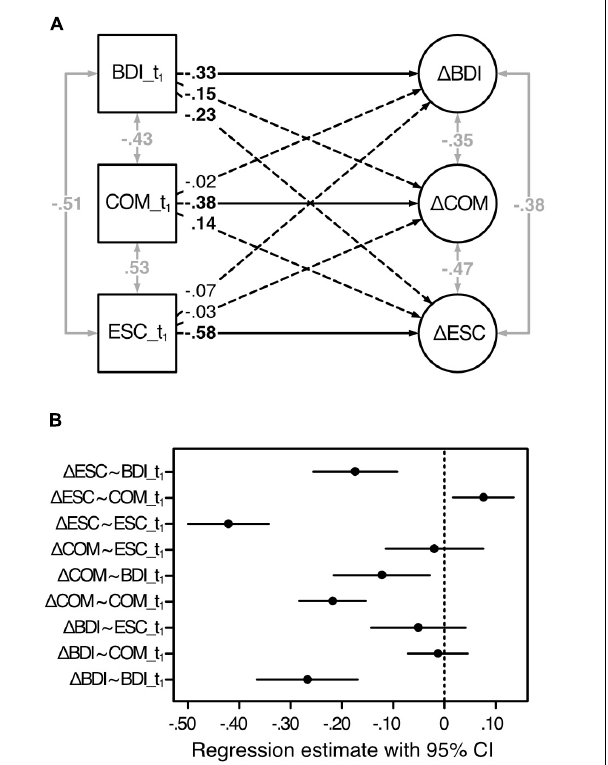
FIGURE 2 | Estimated latent change score model of the change scores predicted by the baseline scores. Analysis based on the first sample ( n 1 = 459). BDI, depressive symptoms; COM, cognitive motivation; ESC, effortful self-control; t 1 , before treatment; (cid:49) , latent change score (i.e., the change from t 1 to t 2 ). (A) Standardized regression coefficients are displayed. One-sided solid and dashed arrows refer to the model in Figure 1 and indicate directed effects (regression coefficients), two-sided gray arrows indicate undirected relationships (correlations). Coefficients in bold are significant for p < 0.05. (B) 95% confidence intervals of the unstandardized regression estimates, based on 1,000 bootstrap